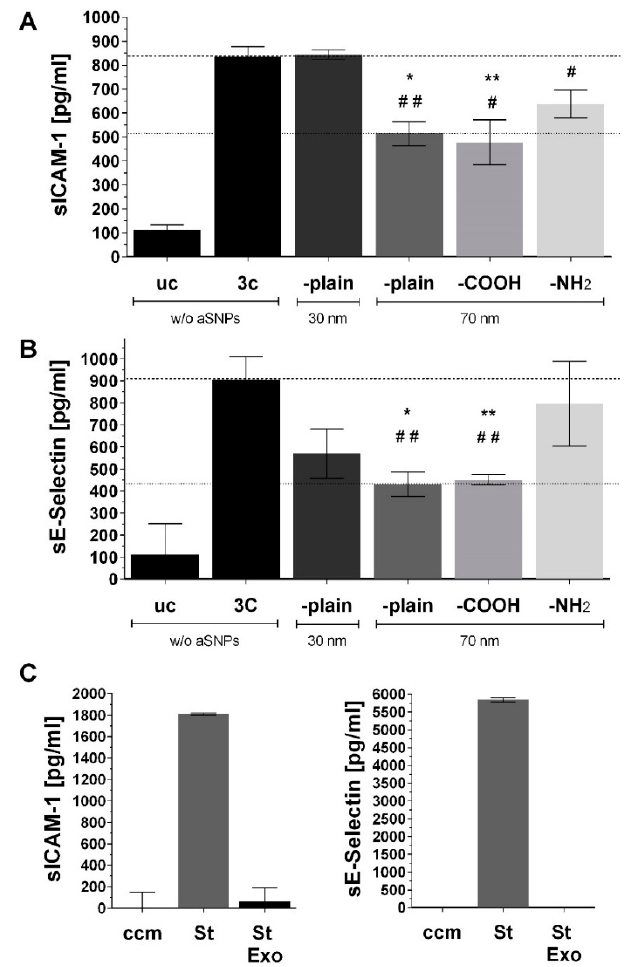
Figure 5. ELISA (enzyme linked immunosorbent assay) of ( A ) sICAM-1 and ( B ) sE-selectin (pg / mL) of the same supernatants (only endothelial side) as used for the ELISA in Figure 4 after total exosome isolation. Stimulation of the inverted coculture CCinc (ISO-HAS-1 / Caco-2) with aSNPs and 3C (cytokine mixture ((IL-1 β (100 U / mL), TNF- α (600 U / mL) and IFN- γ (200 U / mL)) for 48 h; uc: untreated control (without aSNP and 3C); aSNPs: -plain, 30 nm: Sicastar Red with a diameter of 30 nm, without surface modifications; -plain, -NH2, -COOH, 70 nm: Sicastar Red with a diameter of 70 nm and di ff erent surface modifications. All aSNPs were applied in a concentration of 100 µ g / mL. data are depicted as means ± SE of three pooled experiments with n = 3. ( C ) ELISA of control groups St: recombinant protein (sICAM-1: 2000 pg / mL) and sE-selectin: 6000 pg / mL); ccm: cell culture medium; St Exo: recombinant protein, which underwent total exosome isolation procedure. For statistical analysis one-way ANOVA with Dunnett’s Multiple Comparison test was conducted. * and # p < 0.05, ** or ## p < 0.01, (#: comparison to uc; *: comparison with